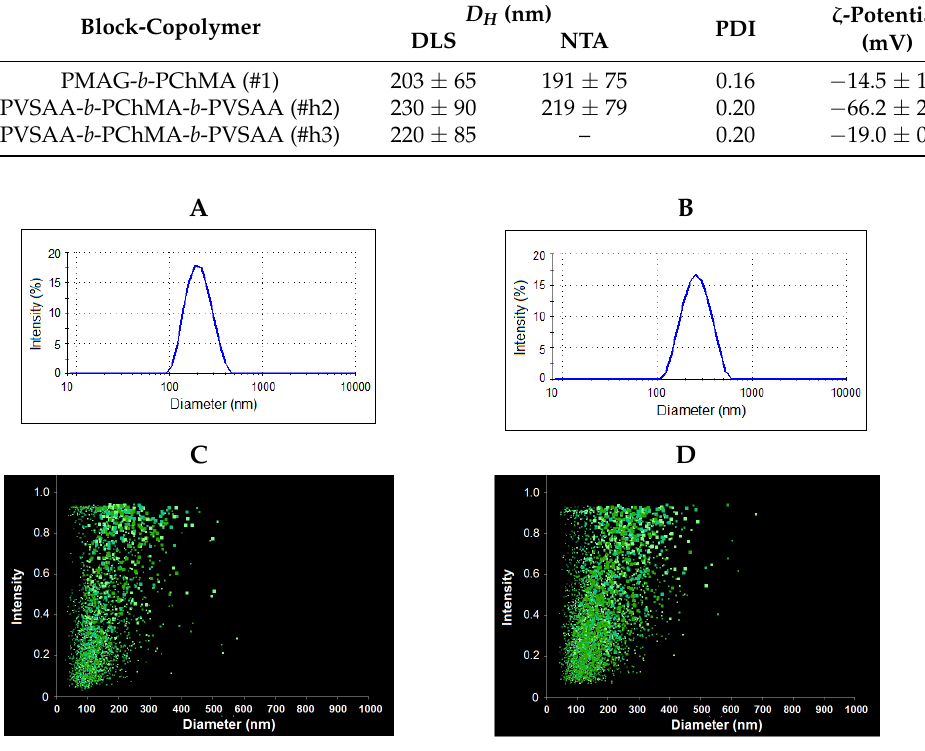
Table 2. Characteristics of the nanoparticles self-assembled from amphiphilic block-copolymers.